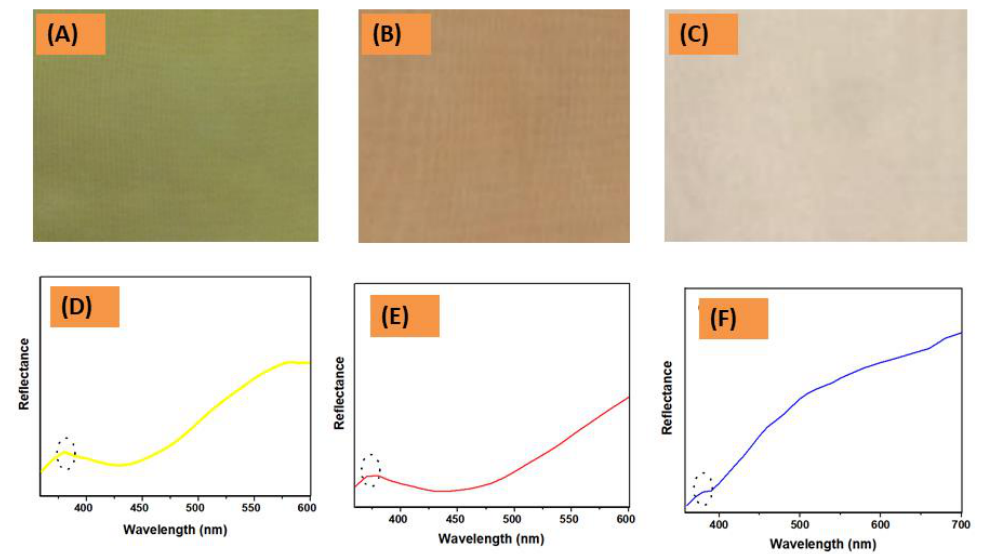
Figure 3. Proposed mechanism of G-AgNPs@PET.